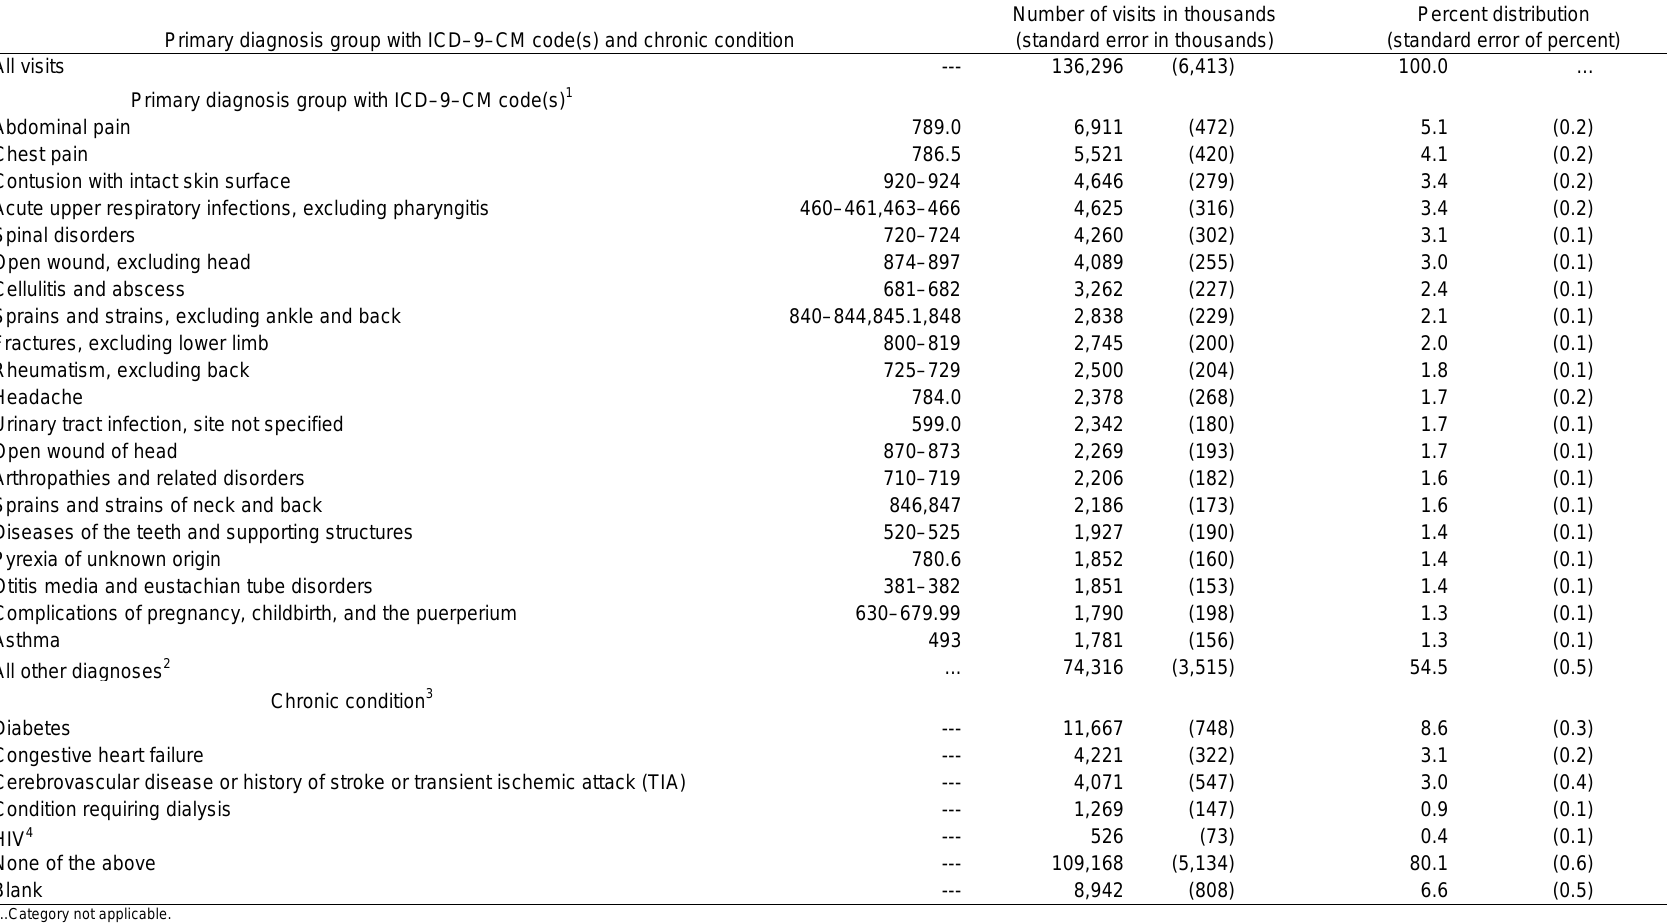
Number of visits in